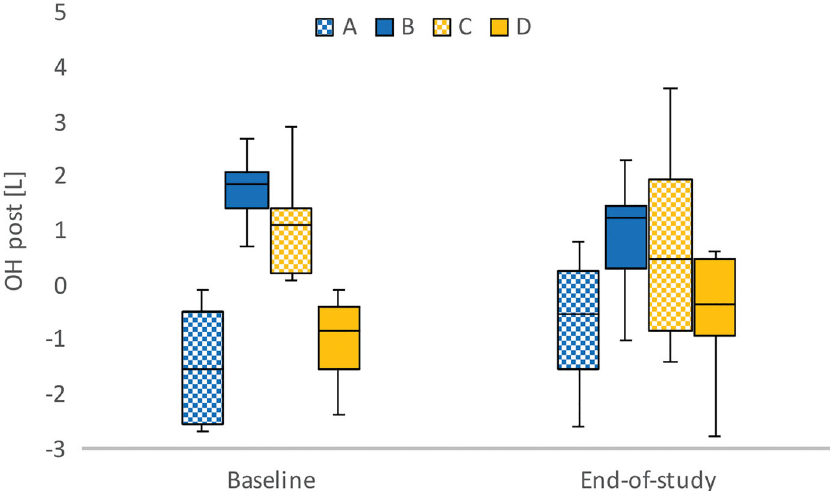
Figure 2. Bioimpedance-measured median overhydration (OH) post in the four groups at baseline and at end-of-study.